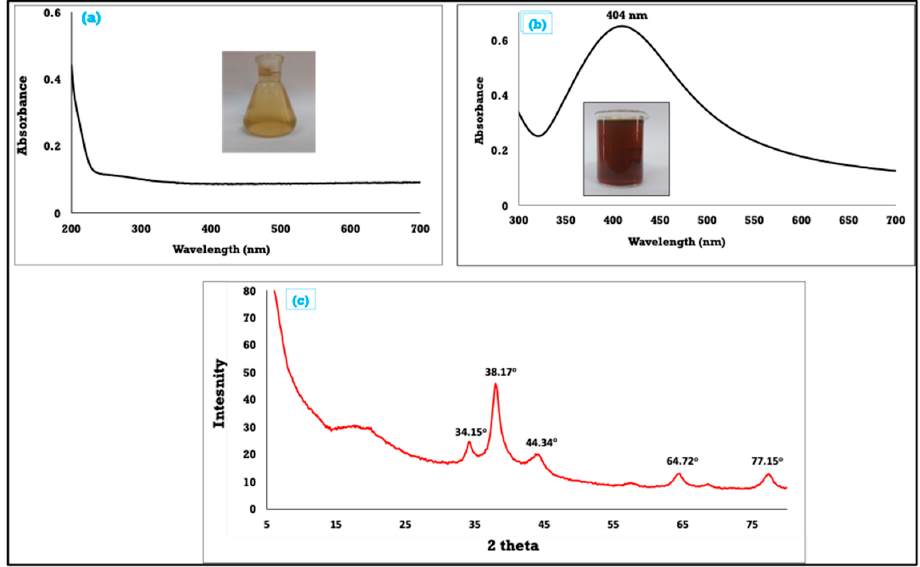
Figure 1. ( a , b ) UV-vis spectroscopy of the extract and AgNPs a© ( c ) XRD of AgNPs.